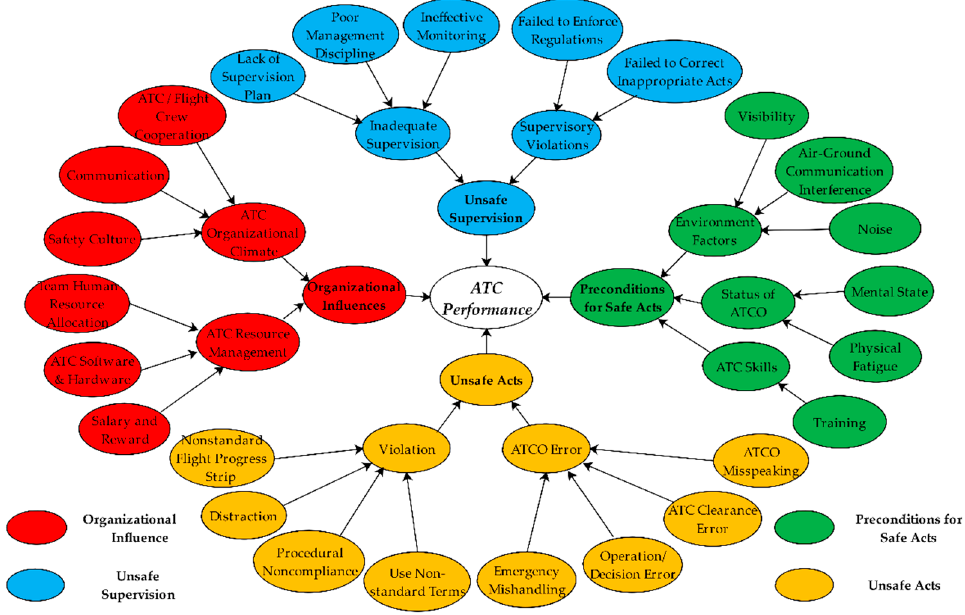
Figure 7. ATC performance model.